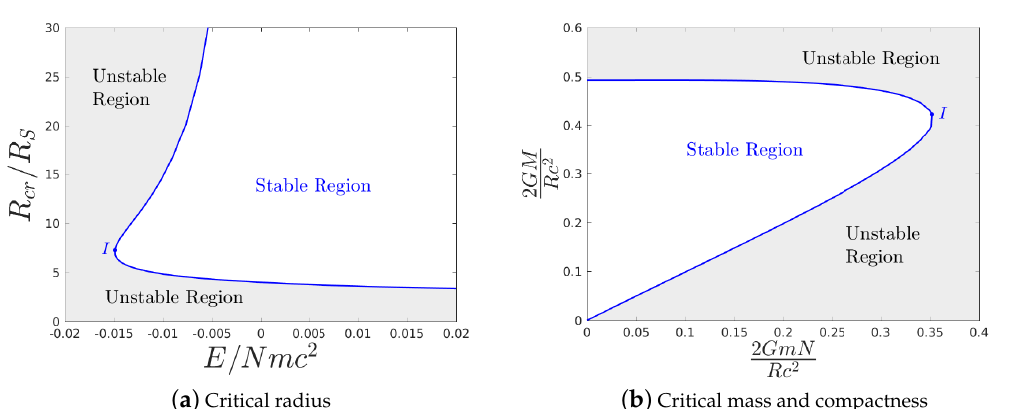
Figure 3. ( a ): The stability domain of scales for a classical, self-gravitating ideal gas under constant energy conditions. For a negative fixed value of gravothermal energy higher than − 0.015 Nmc 2 , there exist two marginal radii, in between which stable equilibria do exist. The minimum corresponds to the high-energy gravothermal instability, while the maximum to the low-energy one. The figure is taken from [6]. ( b ): The stability domain of compactness. For every fixed rest mass compactness, there exist two marginal mass or compactness values, in between which stable equilibria do exist. The maximum corresponds to the high-energy gravothermal instability and the minimum to the low-energy one. No equilibria exist for rest compactness above 0.35 and compactness above 0.5 under any conditions. The figure is taken from